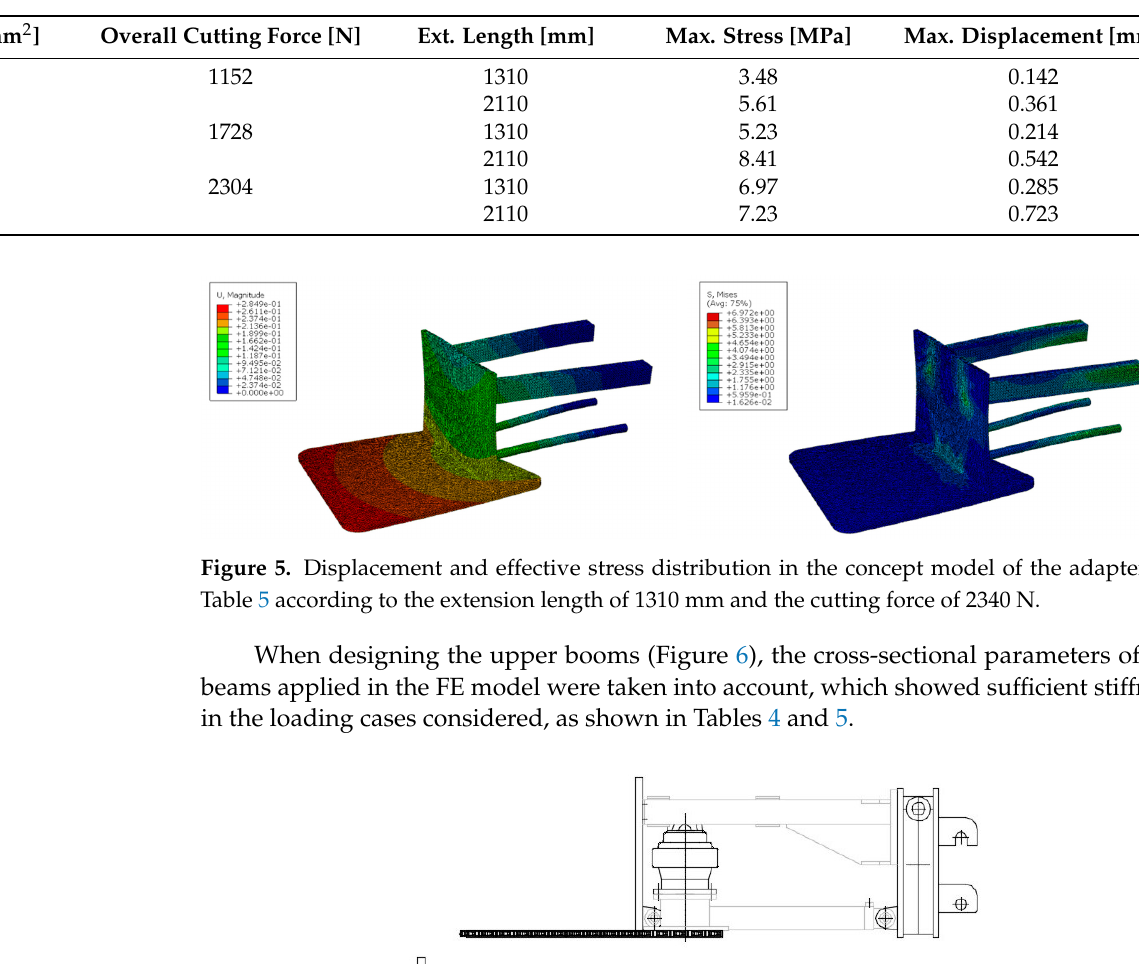
Table 5. Maximum stresses and maximum displacements from the overall cutting forces calculated at the chip surface A chip .